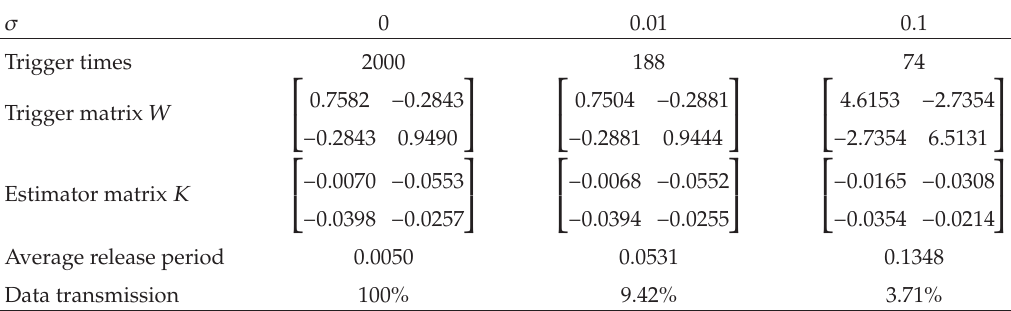
Figure 1: The error curves e i (cid:6) t (cid:7) (cid:6) i (cid:8) 1 , 2 (cid:7) with trigger parameter σ (cid:8) 0 (cid:6) time-triggered scheme (cid:7) . Table 3: h (cid:8) 0 . 005, d M (cid:8) 0 . 01, τ (cid:8) 0 . 1, t (cid:8)